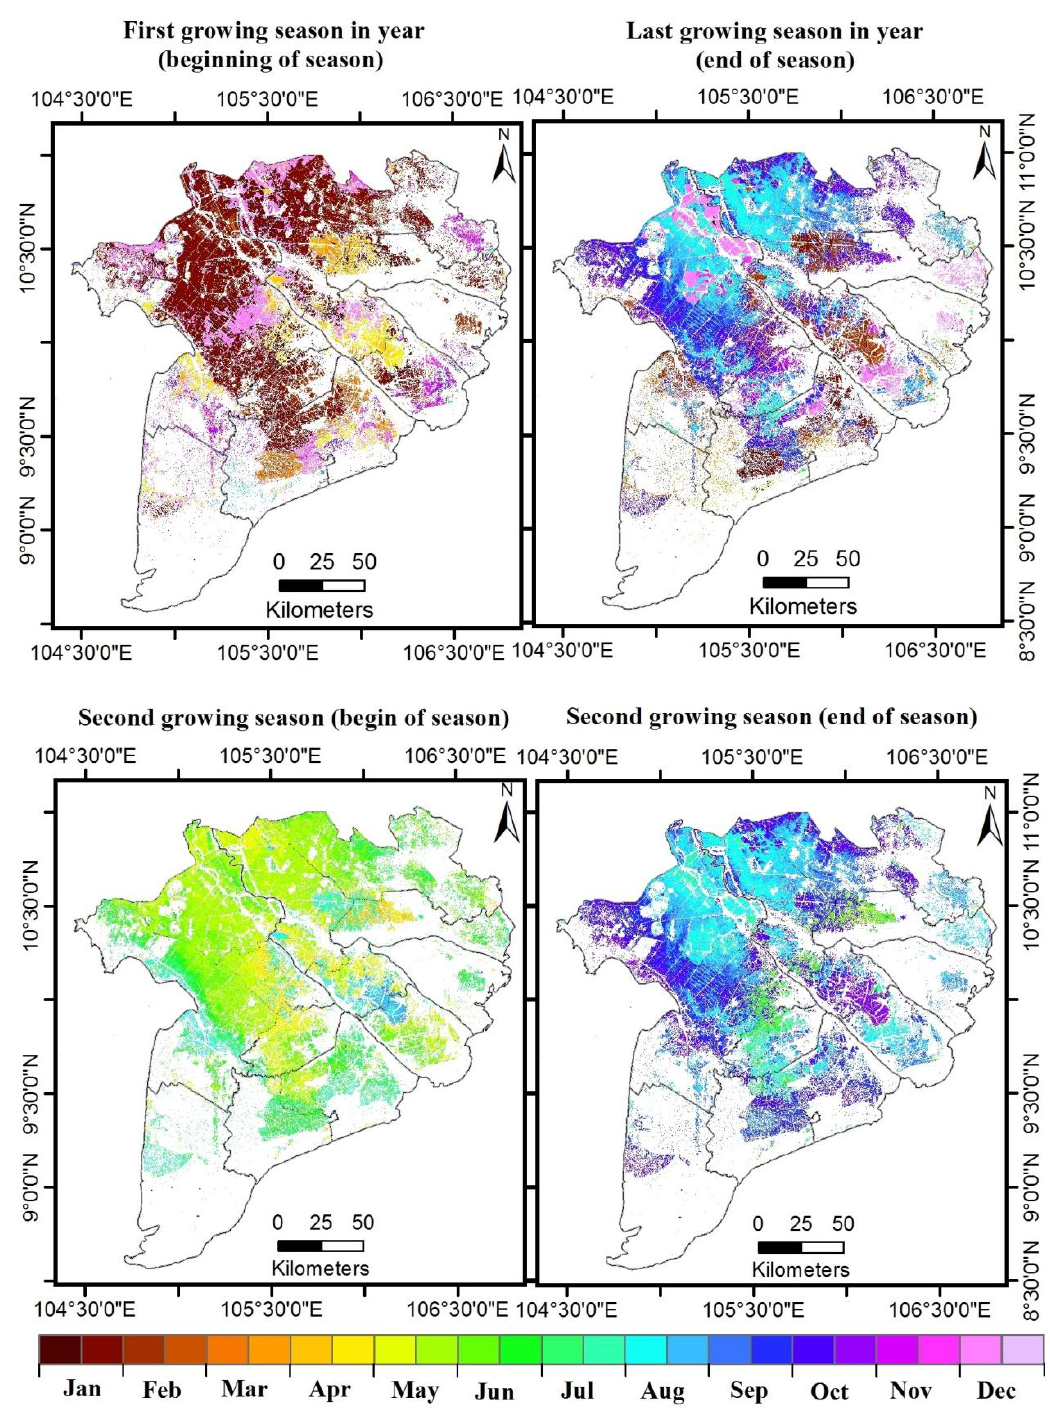
Figure 12. Growing season start and end dates in the Mekong Delta derived from Envisat ASAR WSM data from 2007 to 2011.